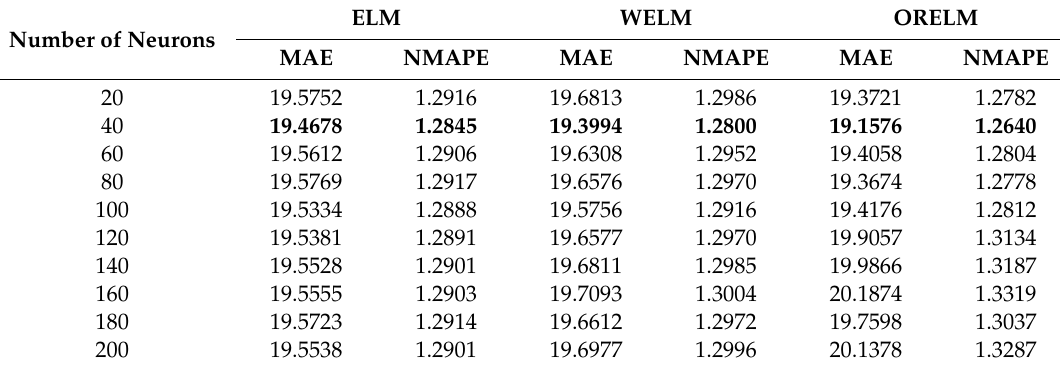
Table 5. Power curve modeling results of ELM-based models on validation set of Dataset B. Number of Neurons